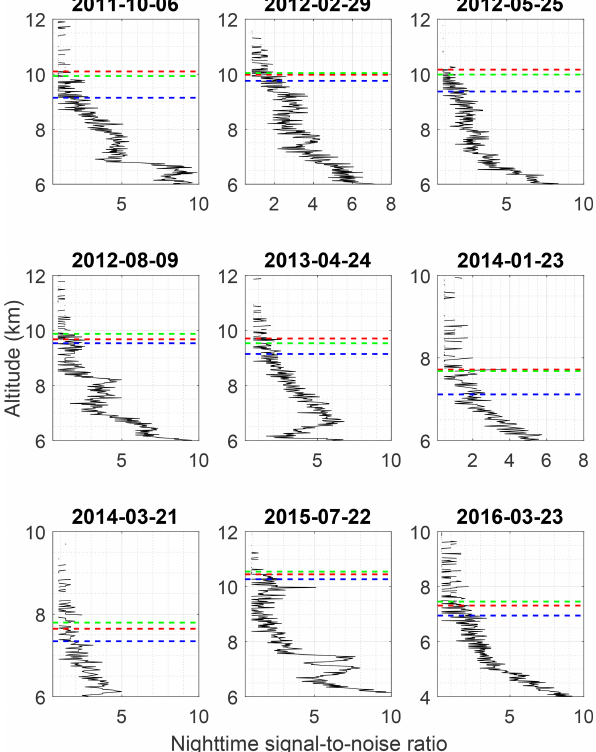
Figure 14. Nighttime SNR calculations for each nighttime water vapor OEM retrieval. The dashed lines are the corresponding cut- off heights: 0.9 measurement response (blue), 0.8 measurement re- sponse (green), and coarse grid (red).